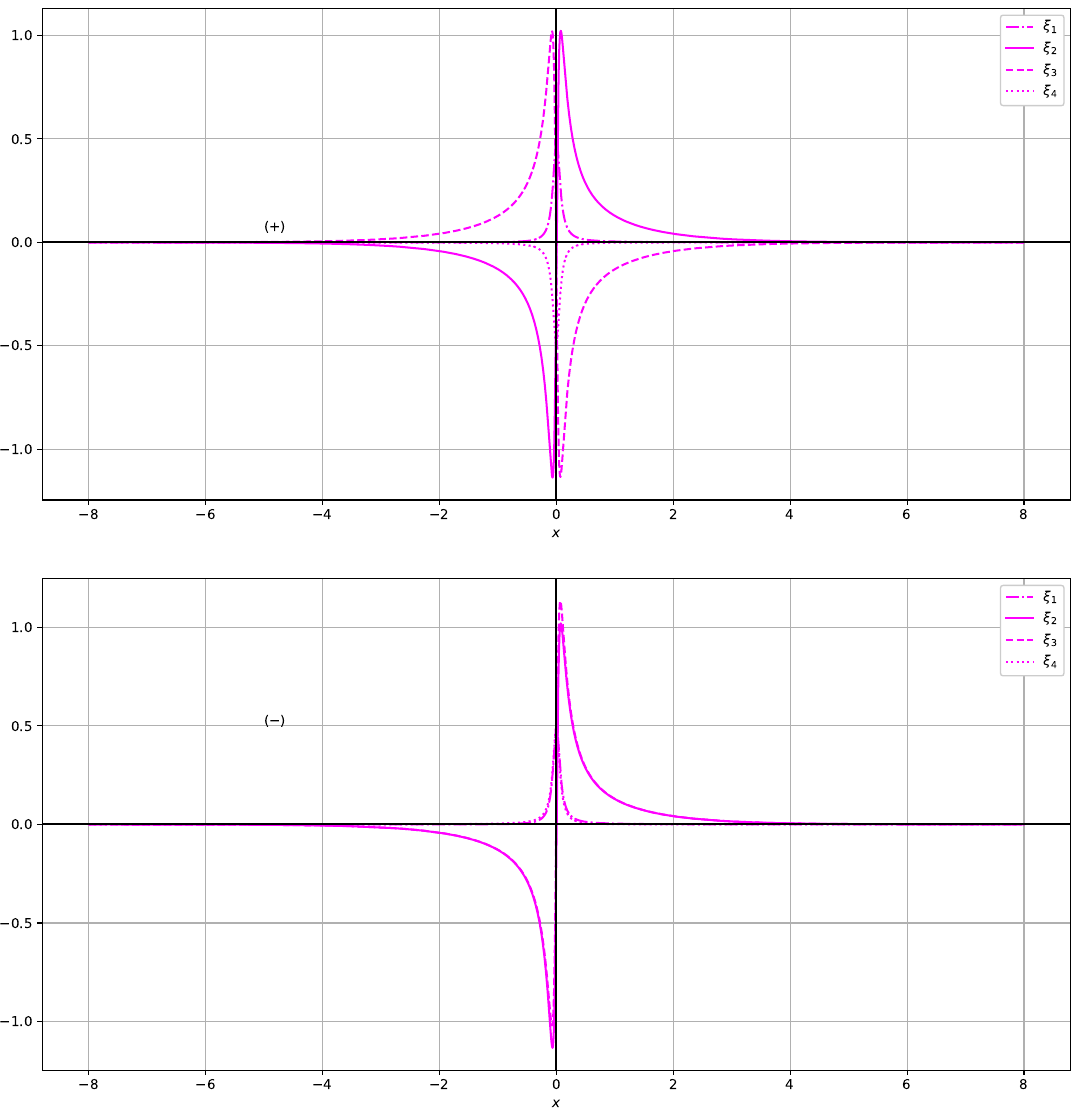
Figure 21 . Numerically simulated bound state components as functions of x for positive parity σ = +1 (Top figure) and negative parity σ = − 1 (Bottom figure). They are hosted by the kink with θ 0 = 3 . 0 (purple kink in the figure